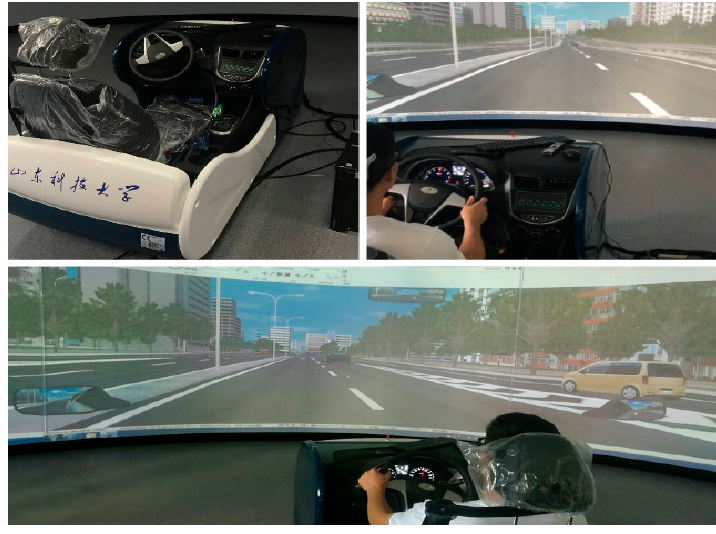
Figure 5. Traffic Simulation Scene of Simulated Driving Test.